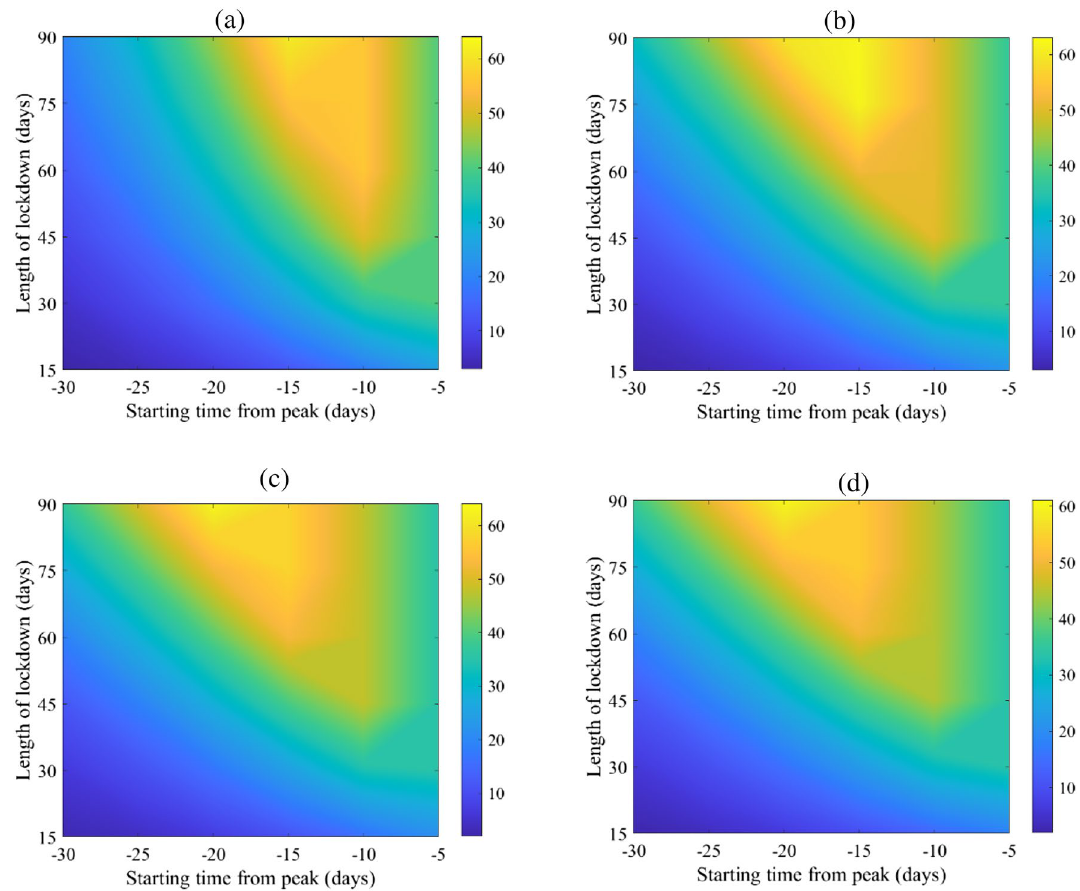
Figure 4. Mean of percentage relative reduction in peak of COVID-19 hospitalization (see Eq. (2)) for ( a ) Canada, ( b ) China, ( c ) Mexico, and ( d ) Niger. They are calculated at R 0 = 6.47 , with initially one adult mild infection. Bars to the right of the figures are